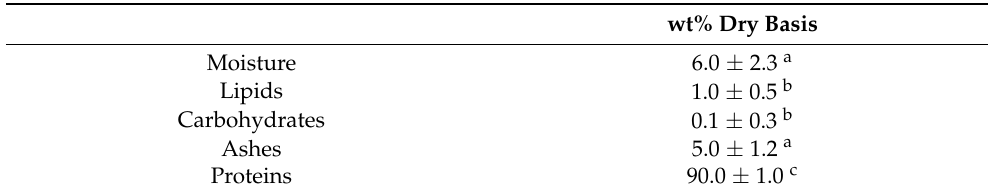
Table 1. Chemical composition of the soy protein isolate. Different letters mean significant differences ( p < 0.05).